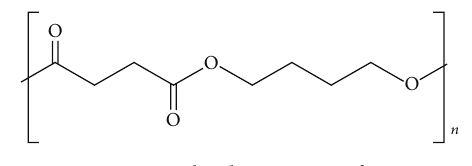
Figure 1: Molecular structure of PBS. Table 1: Chemical and mechanical properties of OPMF and OPEFBF [14].